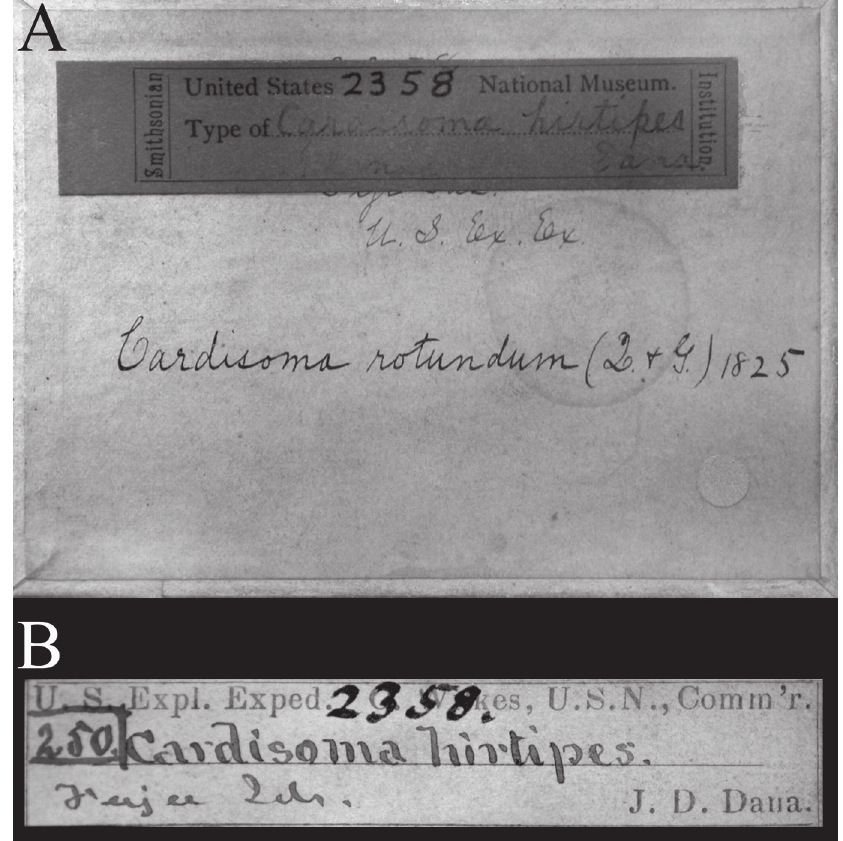
Figure 1. Labels associated with the lectotype of Cardisoma hirtipes Dana, 1851. A, box cover; B, label inside